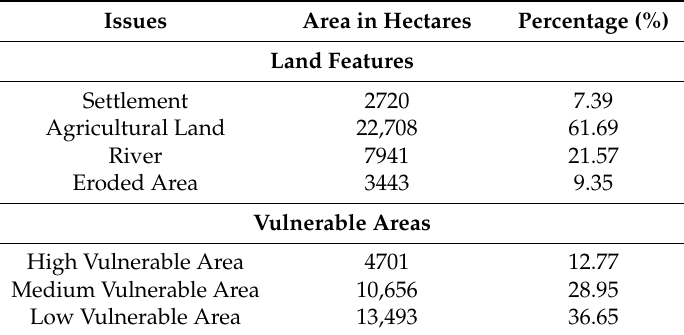
Table 1. Land features and vulnerable areas in study area